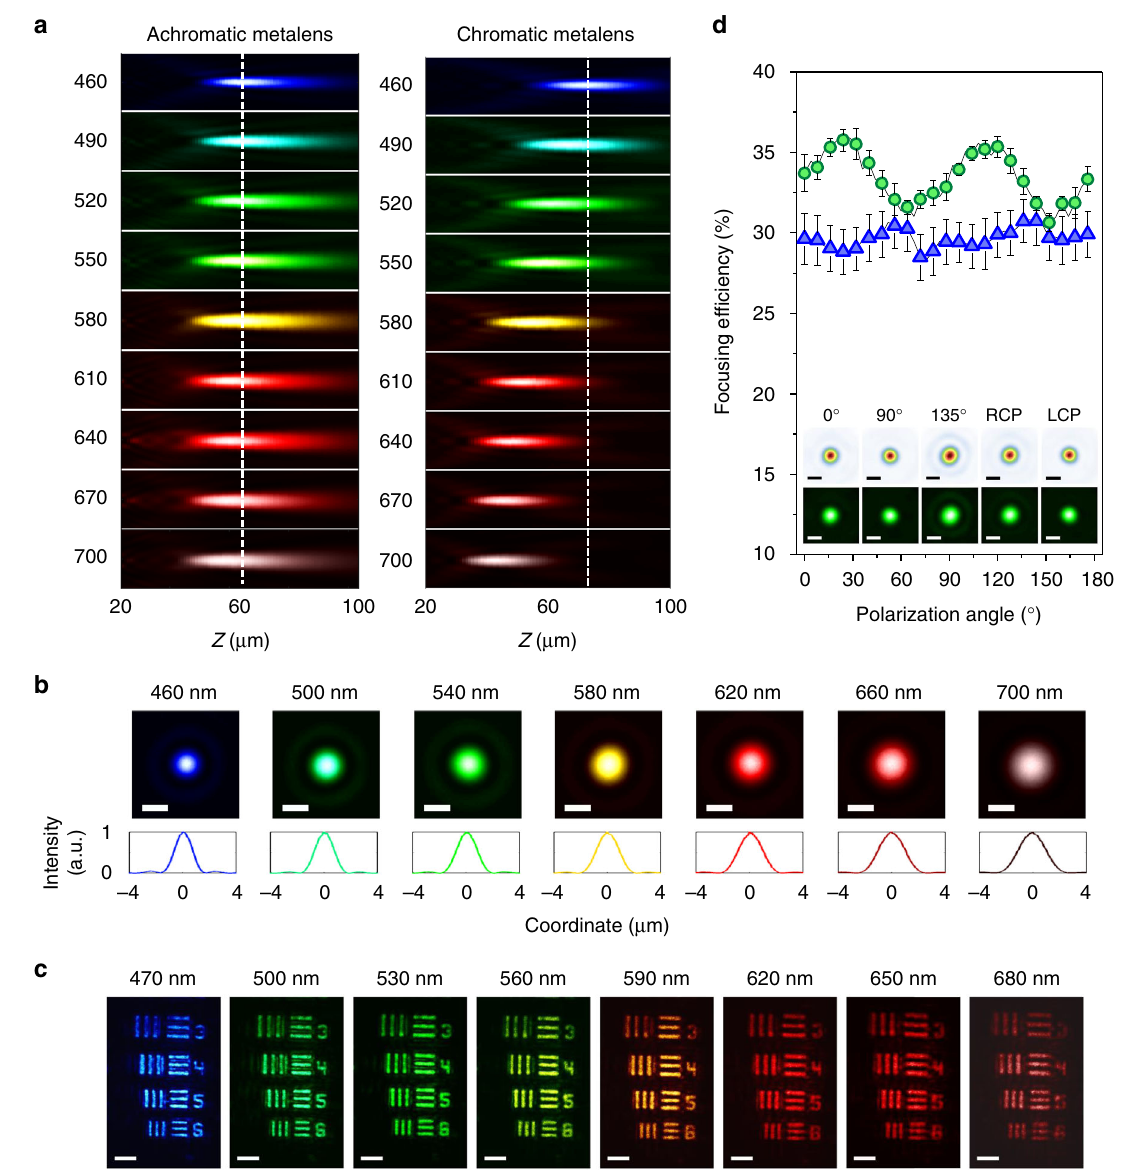
Fig. 3 Measured focal spot pro fi les (in false colors), focusing ef fi ciencies and imaging results. For focal spot pro fi le and focusing ef fi ciency measurements, the metalenses were designed with a NA = 0.2 and a focal length of 67 μ m at λ = 560 nm. a Measured intensity distributions in the y-z plane shown in false colors corresponding to their respective wavelengths in the visible (labelled to left of plots in nanometers). The left and right panels correspond to achromatic and chromatic metalenses respectively. The latter, as a control sample, was designed without dispersion engineering and has a focal length shift similar to that of Fresnel lenses. Incident light travels along the positive z -axis. b Normalized intensity pro fi les along the white dashed lines of (a) for the achromatic metalens. The position of the dashed line corresponds to the focal length at λ = 460 nm. c Imaging with an achromatic metalens of NA = 0.05 and a diameter of 120 μ m. The target is a standard USAF resolution chart. The pattern corresponding to number 6 has a linewidth of 8.77 μ m. The light source is a tunable laser whose center wavelength is labelled on the top, and a bandwidth of 40 nm. The colors, brightness and contrast were adjusted for better visualization. A pair of polarization polarizer and analyzer was used to remove background light. Scale bars: 40 μ m. d Focusing ef fi ciency of the achromatic metalens (NA = 0.2) as a function of the angle of linearly polarized incident light in steps of 4°. The error bars span a range of two standard deviations. The illumination light sources are alternately a single wavelength 532 nm diode laser and a tunable broadband laser with 200 nm bandwidth centered at 570nm. The measured focusing ef fi ciencies using the monochromatic and broadband light source are represented by the green and blue symbols, respectively. The inset shows the focal spot pro fi le, with the top and bottom rows corresponding to the diode (monochromatic) and tunable broadband laser illumination, respectively. The polarizations of input light are labelled at the top. Scale bars: 2 μ